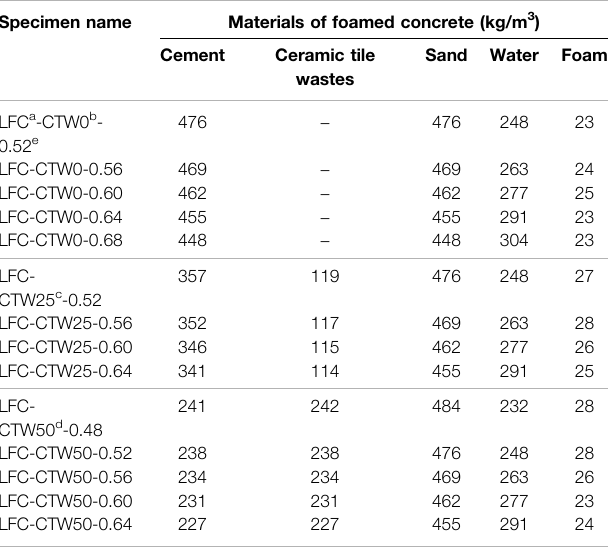
TABLE 2 | Mix proportion of LFC-CTW0, LFC-CTW25, and LFC-CTW50 with various water-to-cement